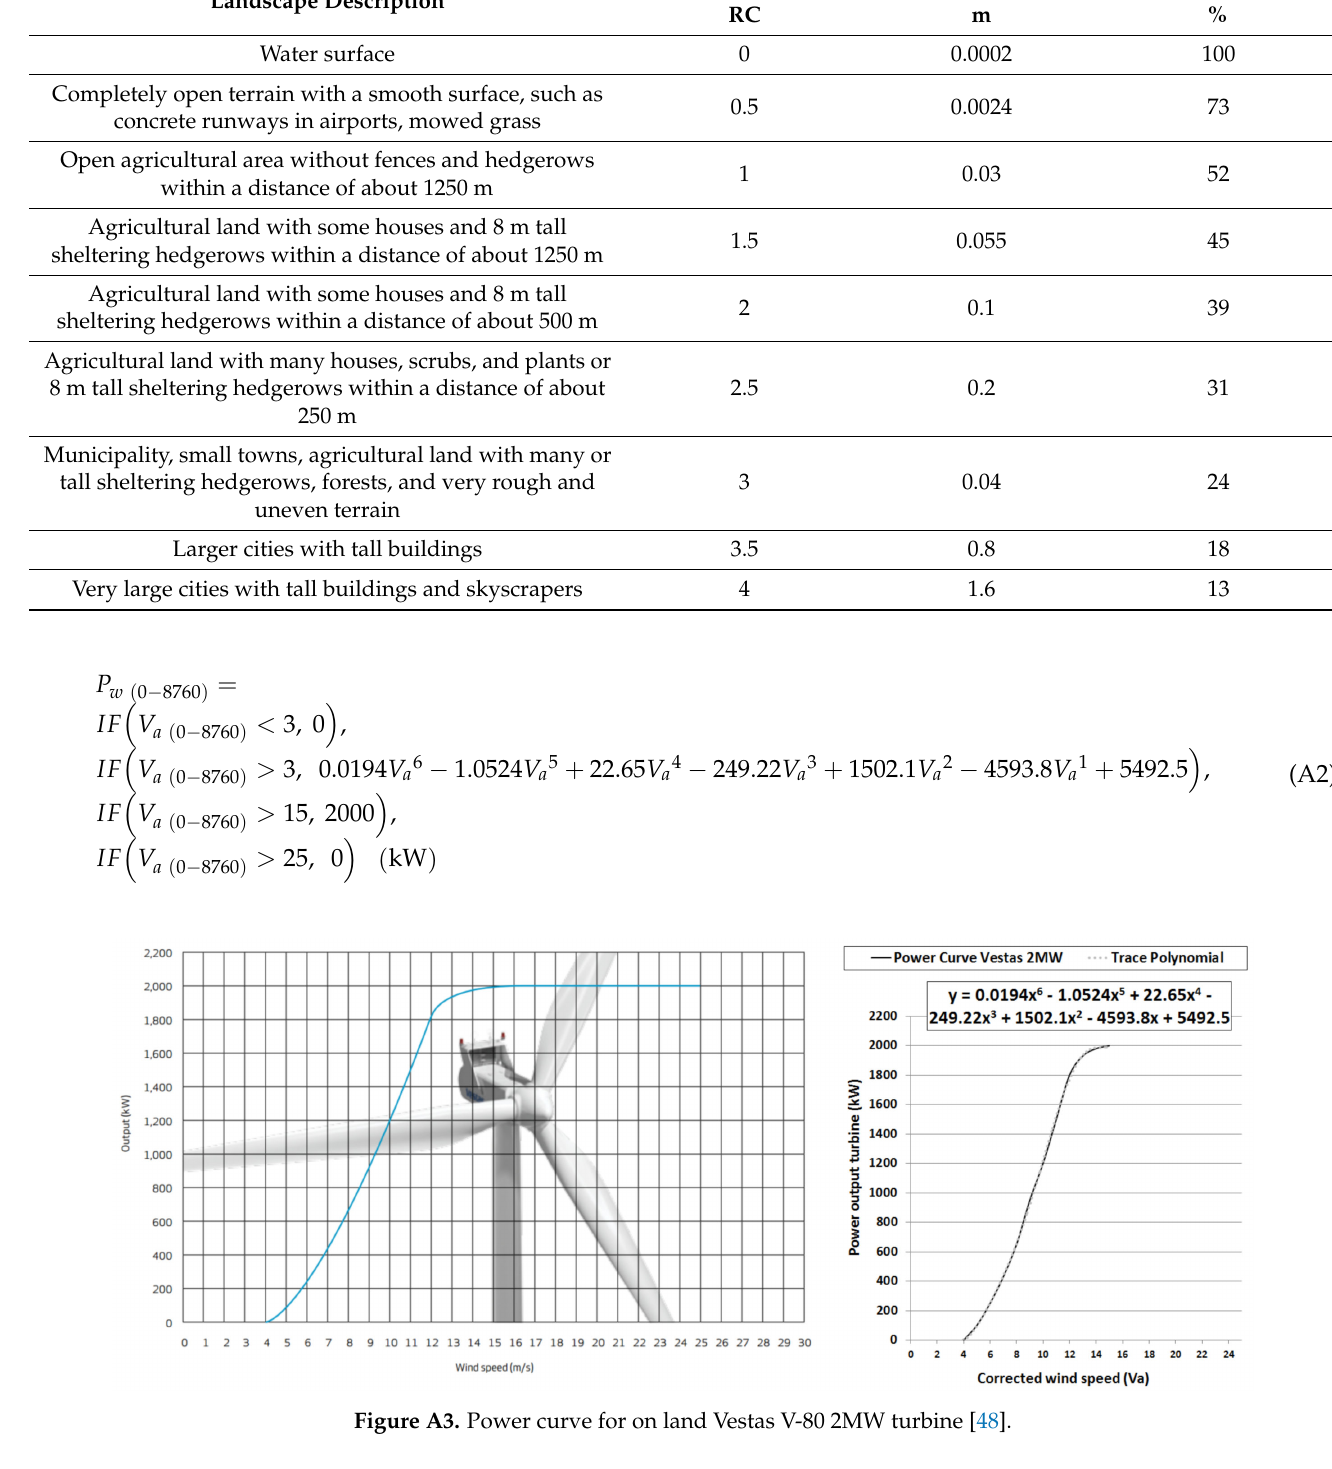
Table A6. Table used for determination of roughness class for wind speed correction calculation. Landscape Description